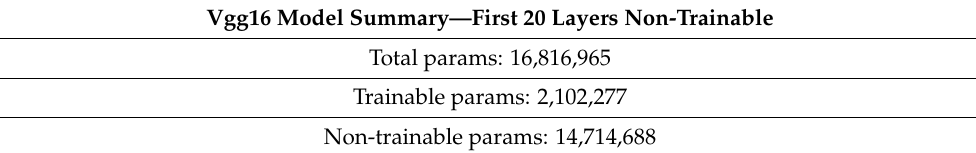
Table 2. Vgg16—model summary for first 20